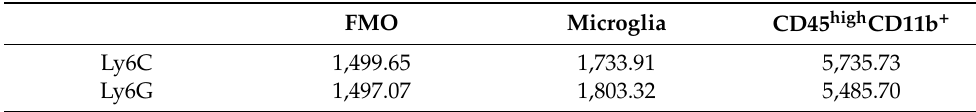
Table 5. Mean fluorescence intensities (MFIs) of Ly6C/G